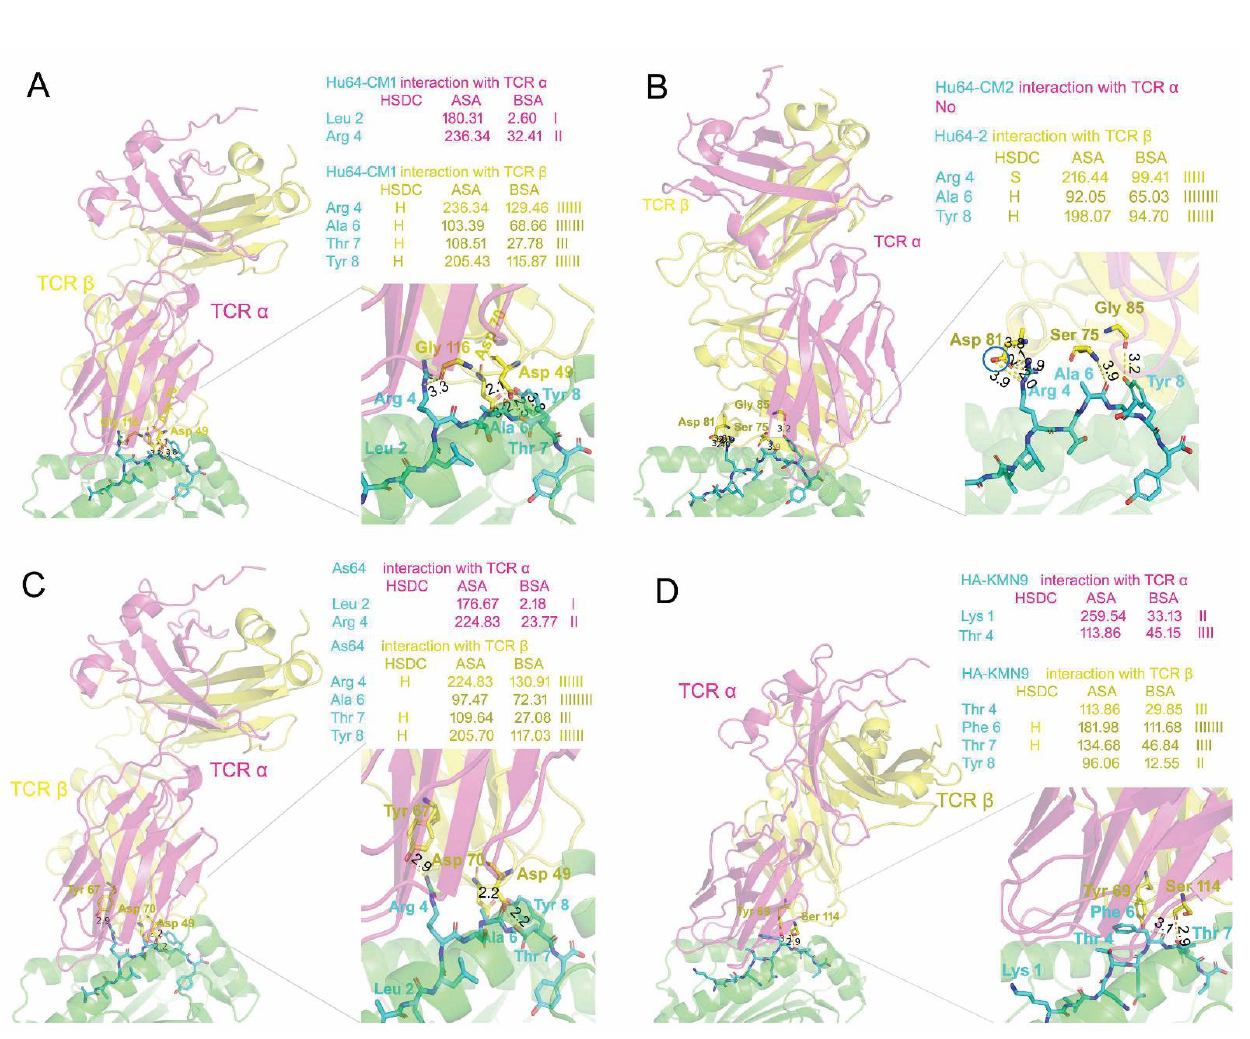
distance between the amino acids from TCR and the amino acids from peptides. The threshold for